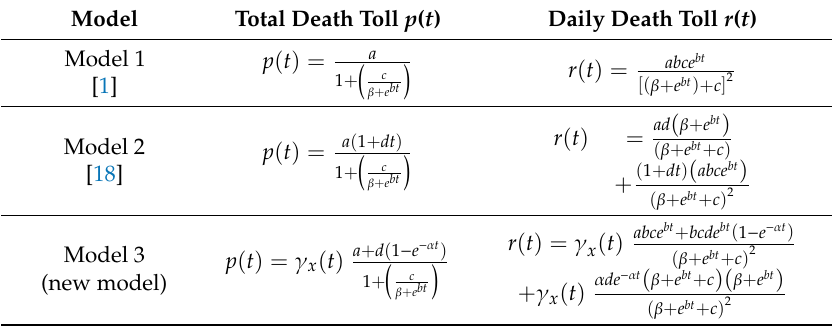
Table 1. The total and daily death toll functions of the proposed and recent